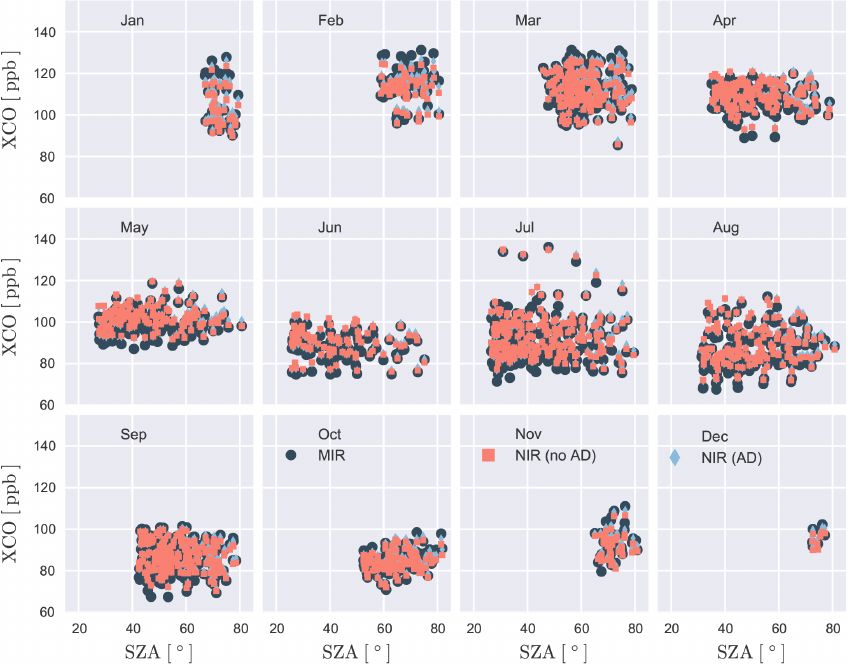
Figure A4. Air-mass-dependence of XCO split in months for NDACC (MIR) and TCCON with (AD) and without air-mass-dependent correction factor (no